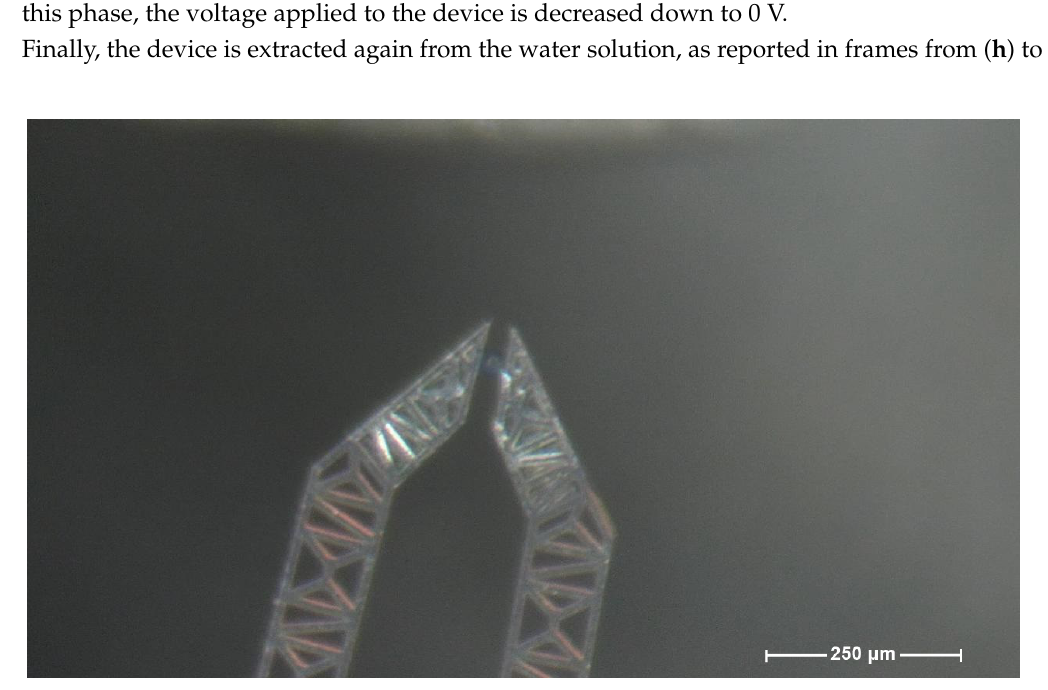
Figure 6. A frame from the sequence reported in the Figure 7 (releasing).